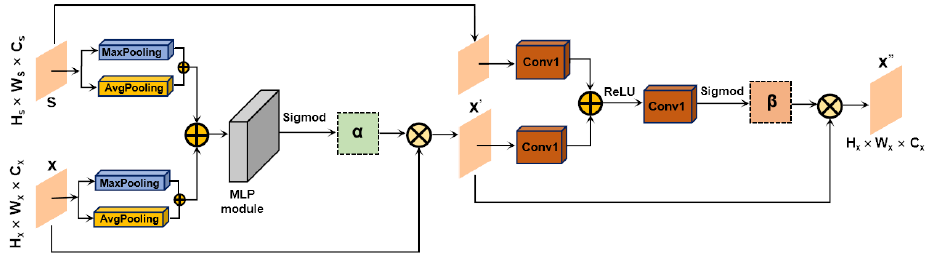
Figure 4. Diagram of the hybrid attention